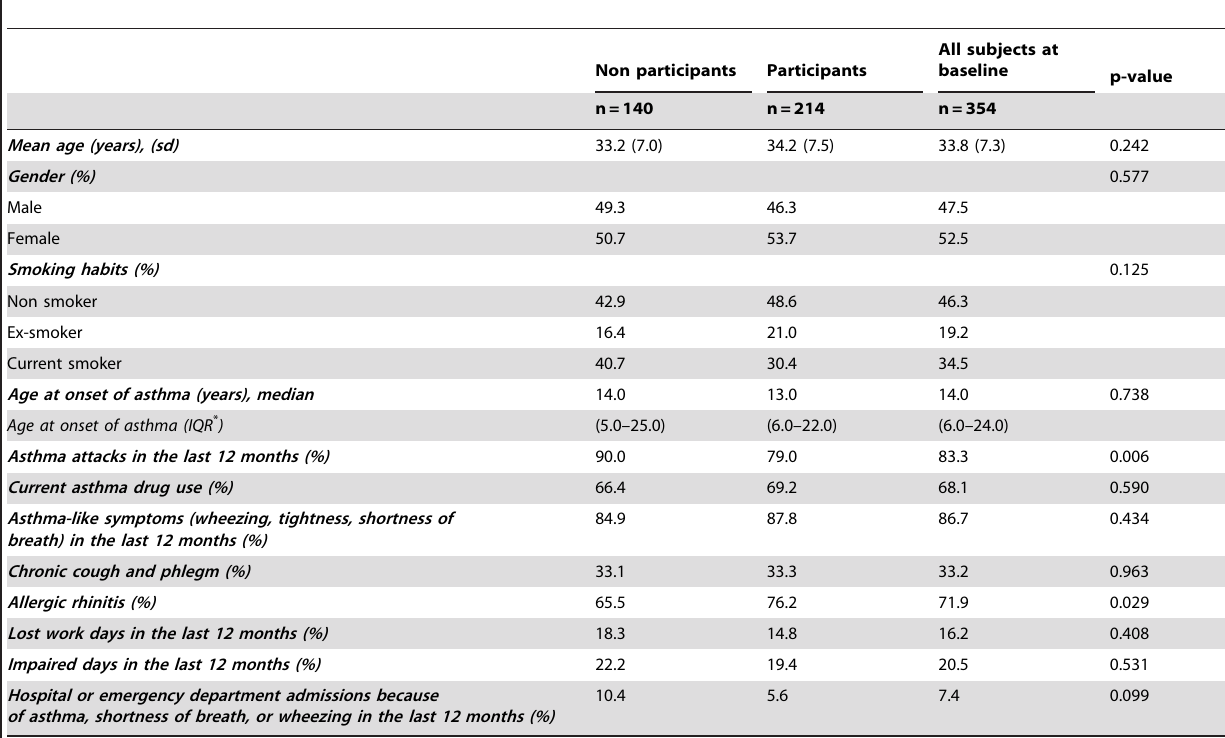
Table 1. Main baseline characteristics of the subjects participating and not participating in the follow-up